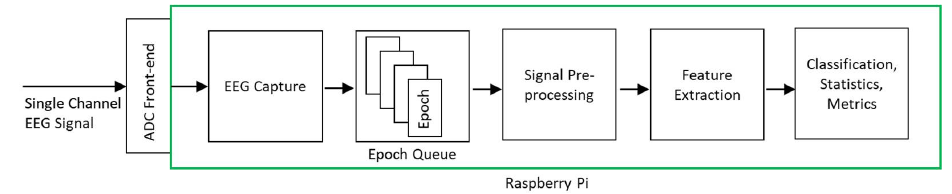
Figure 2. Proposed system architecture.